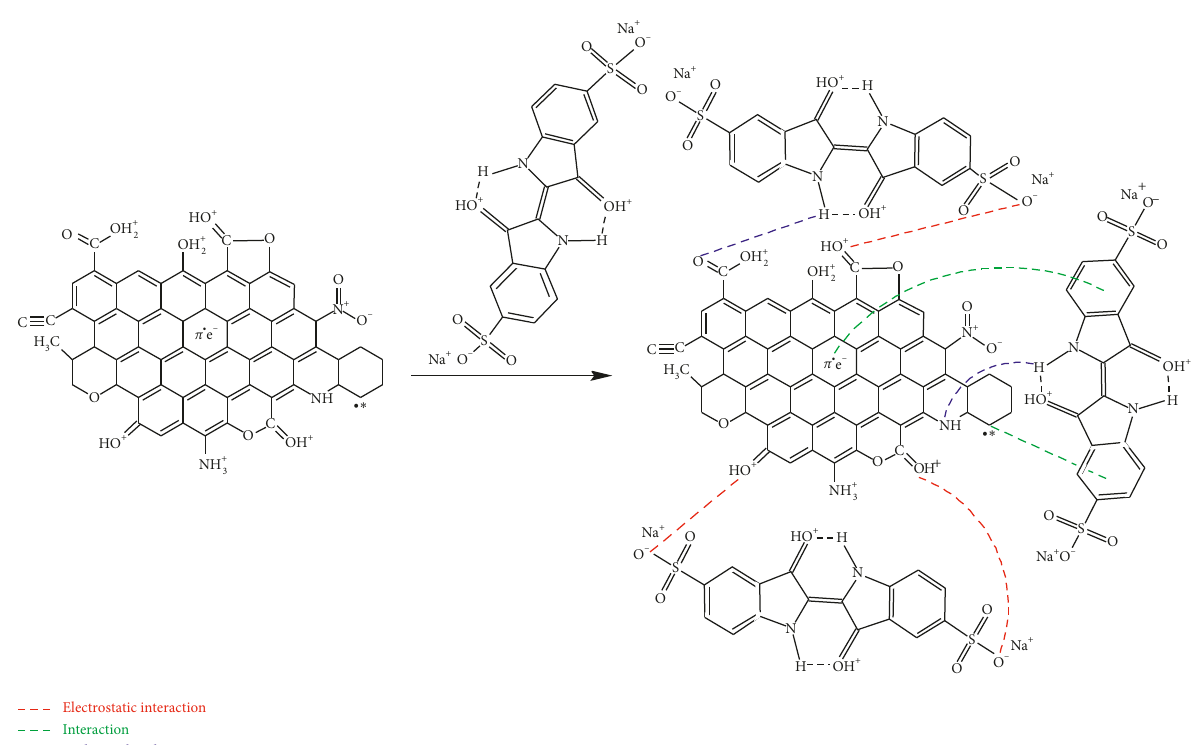
Figure 16: Probable mechanism involved during adsorption of IC by activated carbons.